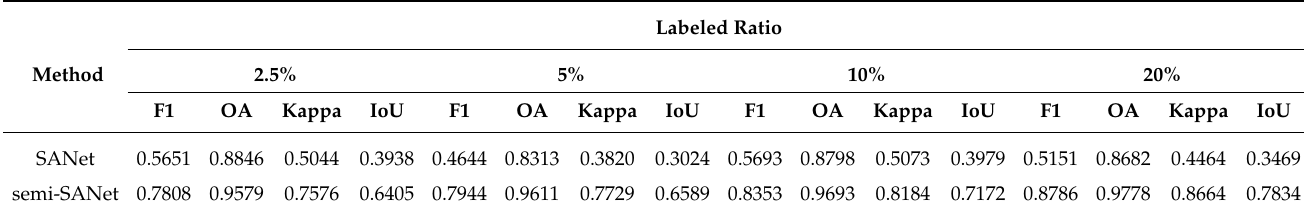
Table 5. The experimental results for the WHU